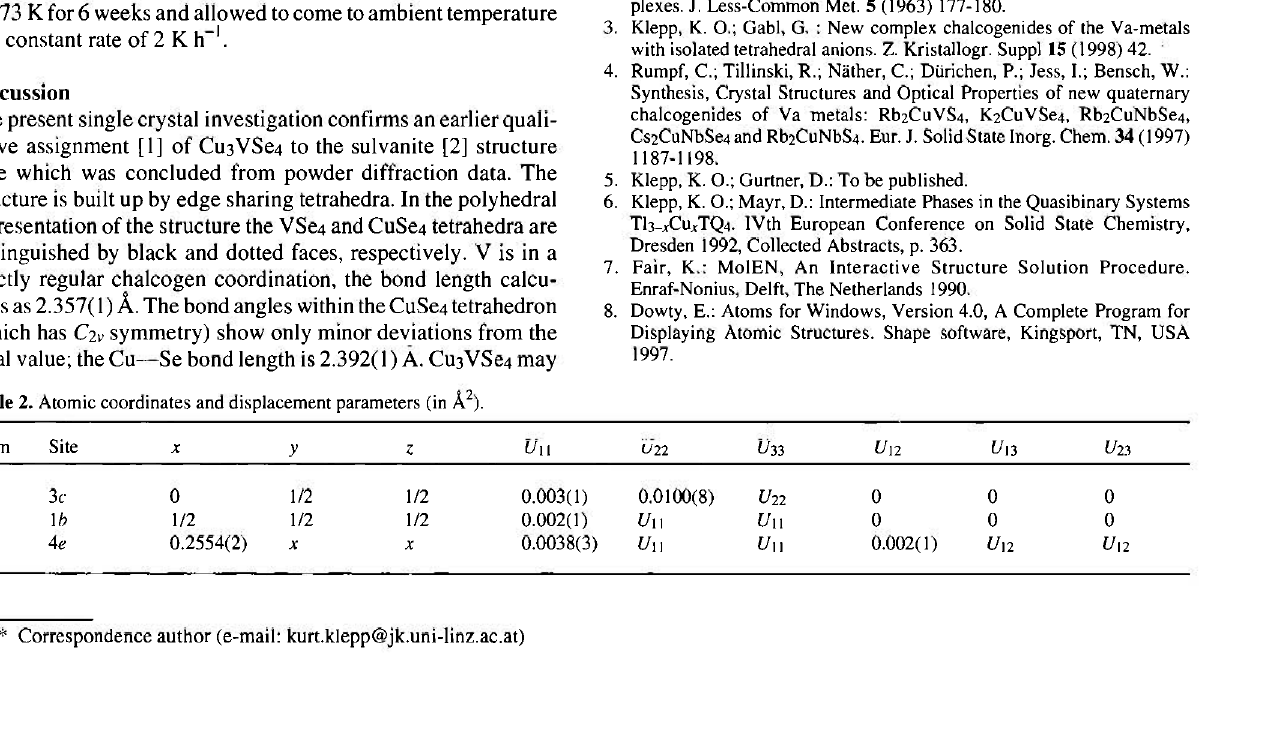
Table 1. Data collection and handling.